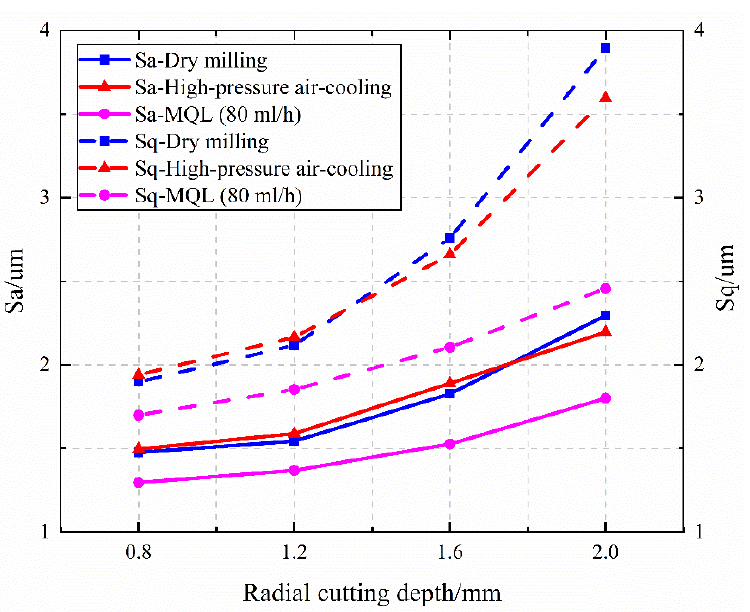
Figure 15. The effect of milling speed on surface roughness Sa and Sq. ( a e = 1 mm, a p = 2 mm, f z = 20 µ m/z).